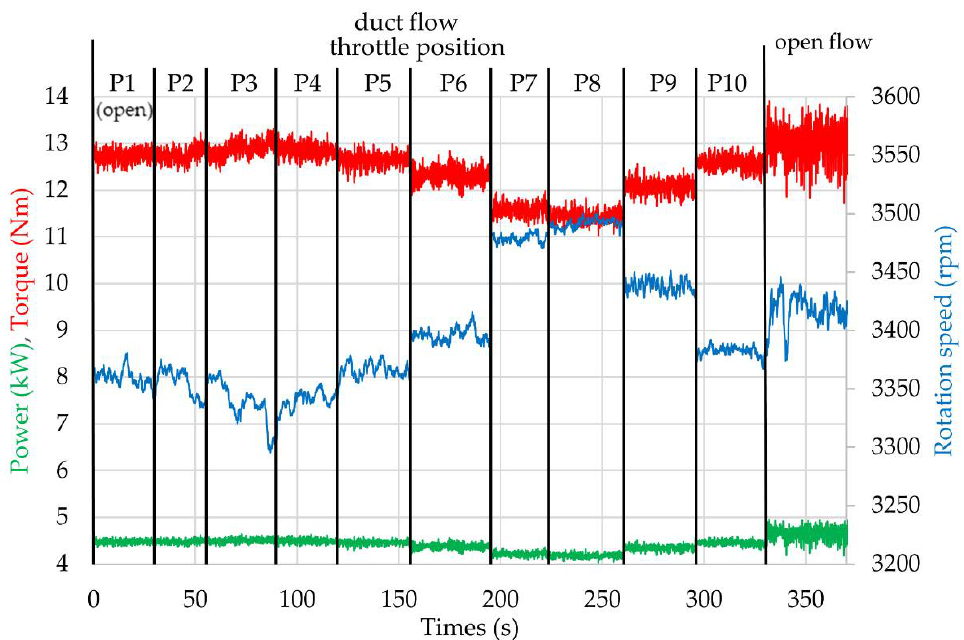
Figure 6. Power, torque, and speed during tests of fan W2 using Method A (duct flow) with variable damper closure and Method B (open flow).